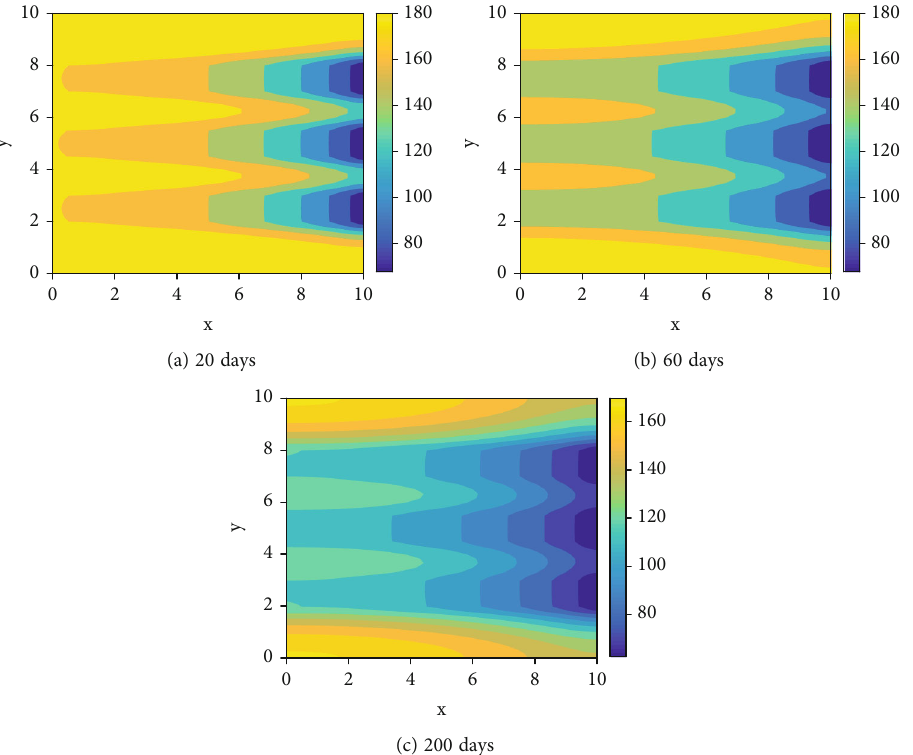
= 60 mol/m 3 at di ff erent b